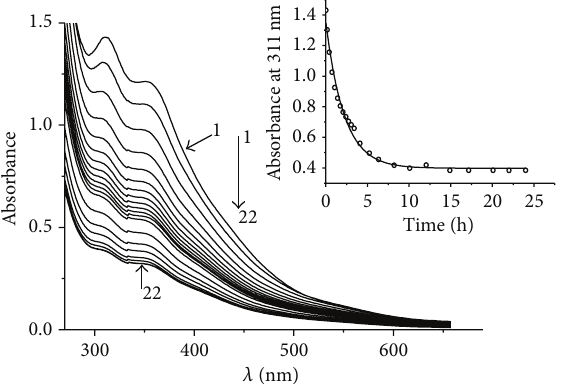
Figure 8: Kinetics of absorption changes in the interaction of ( I ) ( 1.5 ⋅ 10 −4 M) with GSH (10 −3 M): spectra were registered at 45s (1) , 5min (2) , and 20min (3) after start of reaction. Spectra 4–18 were registered further with interval 20 min. Spectra 19–28 were registered at 7.3 (19), 9.4 (20), 11.8 (21), 13.8 (22), 16.3 (23), 19.5 (24), 21.5 (25), 22.8 (26), 23 (27), and 24 (28)h after start of reaction. Conditions of reaction: 25 ∘ C, solvent is 0.05 M Tris-HCl buffer, pH 7.0. Spectra 1–28 have 2 maxima: 𝜆 1 = 315 nm and 𝜆 2 = 367 nm. The inset shows kinetics of ( II ) accumulation at interaction of ( I ) with GSH on the base of the experimental data shown on this figure.Circlesaretheexperimentaldata.Approximation(theoretical + 𝐴 ⋅ 𝑒 −𝑘𝑡 . ( I ) is the complex curve) was made by means of 𝑦(𝑡) = 𝑦 o ( SC ) ( NO ) ] SO ⋅ 5 H II ) is the complex [ Fe 2 5 H 11 NO 2 4 4 2 O, and ( 2 [